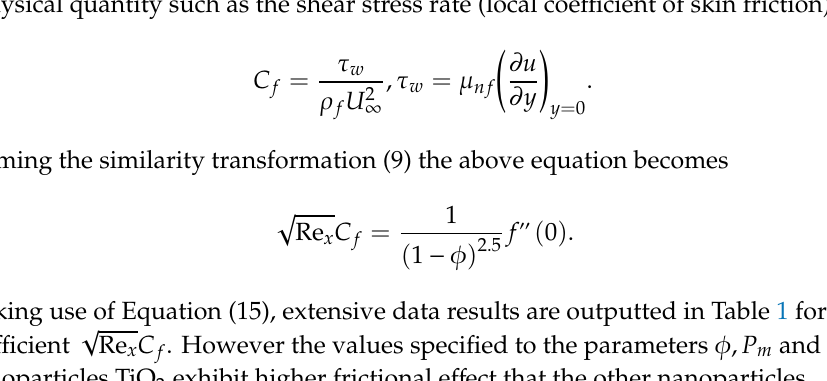
Table 1. Numerical data set for skin friction of three di ff erent types of water-base nanofluids. φ P λ m t